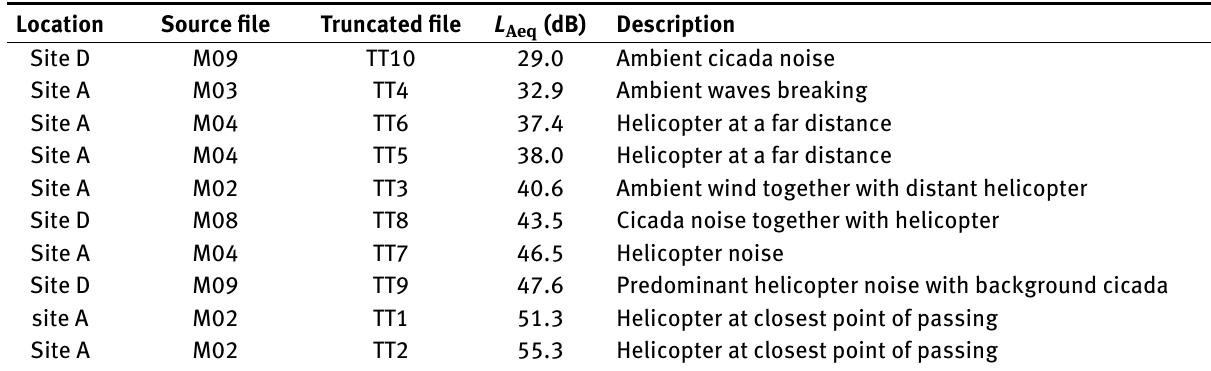
Table 2: Audio stimuli used in tranquillity assessment Location Source